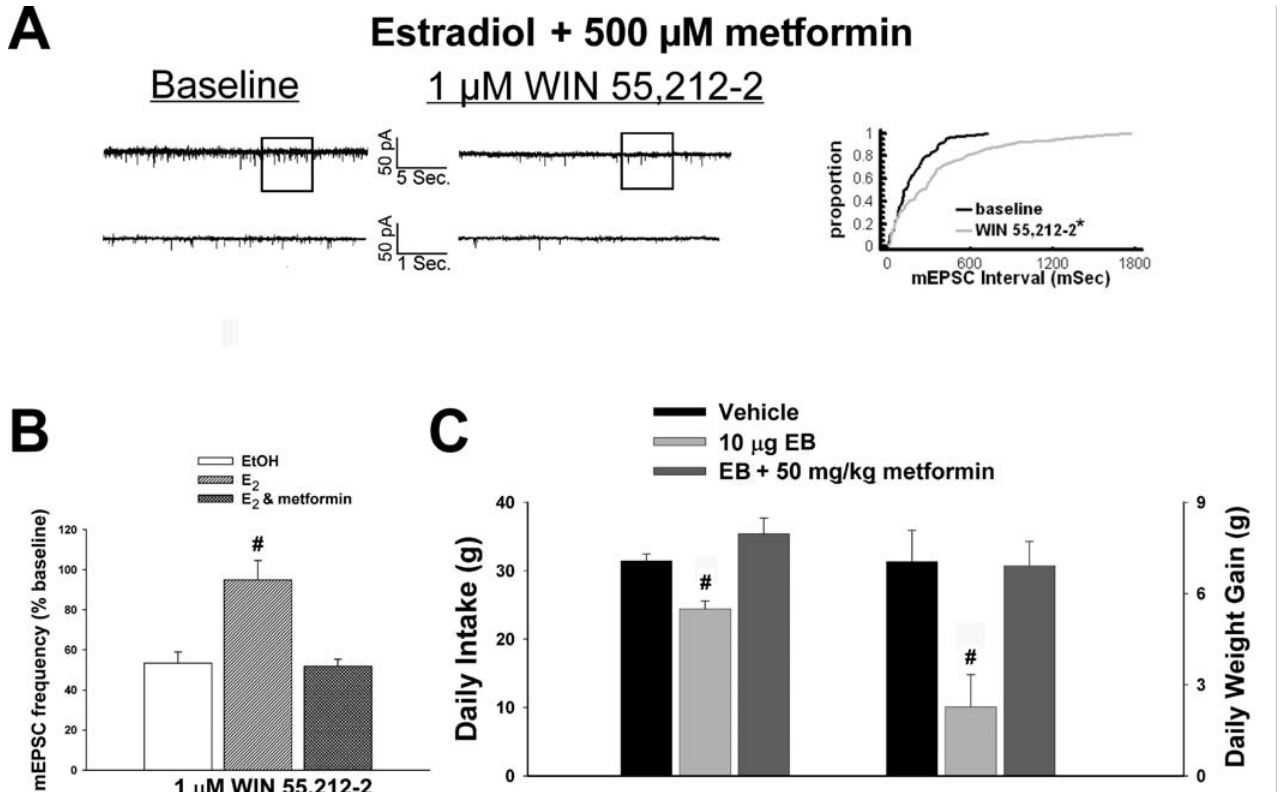
A , Spontaneous mEPSCs recorded in a neuron co-administered 100 nM E metformin at baseline (left) and following exposure to 1 μ M WIN 55,212-2 (right). To the right of the membrane current traces is the cumulative probability plot illustrating the